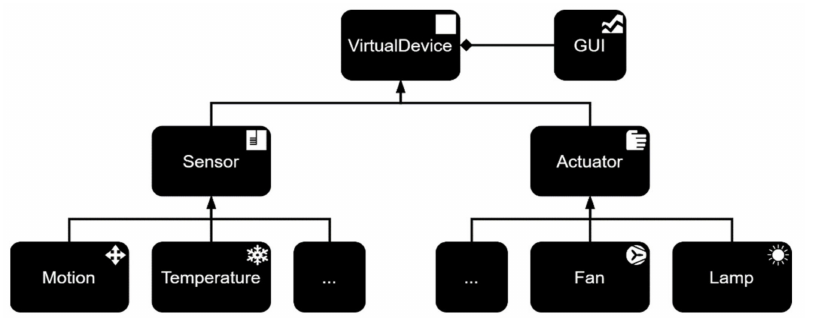
Figure 3. VirtualDevice structure and generalization: it is composed of a representational state and it can be specialized in Sensor or Actuator